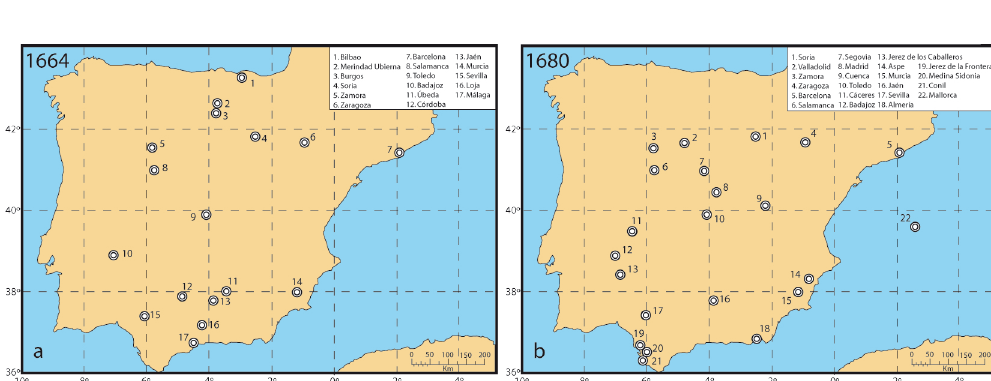
Fig. 3. Sites with a drought documentarily registered in spring 1664 (a) and spring 1680 (b) . – Spring 1664: the only drought affecting to all the seven sites with rogation series (Fig. 3a and Table